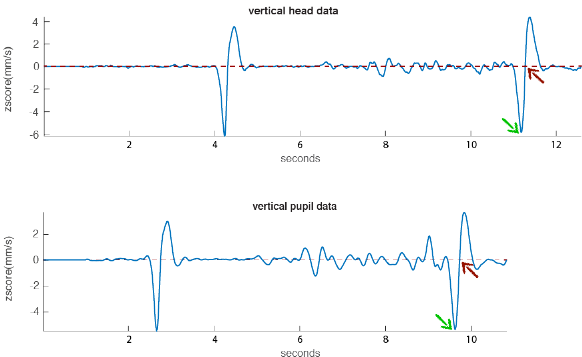
Figure 7. Illustration of the end nod with the z-scored velocity data. The green arrow indicates the local minima exceeding the threshold of -2 corresponding to the end nod. The red arrow in- dicates the subsequent zero-crossing that was used as sync